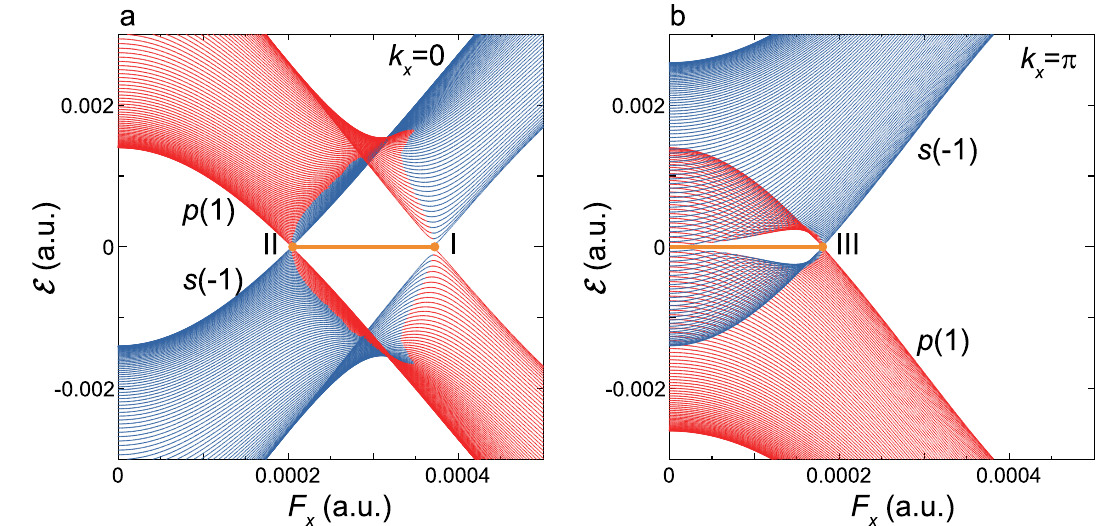
Figure 2. Band inversion and band crossing. ( a ) Shown are E p ( 1 ) ( k x ) and E s ( − 1 ) ( k x ) for k x = 0 as a function of F x . The two quasienergy bands p (1) and s ( − 1 ) (shown by red and blue lines, respectively) cross when F x is fine- tuned at the positions of I and II. Shown are the zero modes (Dirac nodes) by a yellow solid line. ( b ) The same as the ( a ) but for k x = π . The two quasienergy bands cross when F x is fine-tuned at the position of